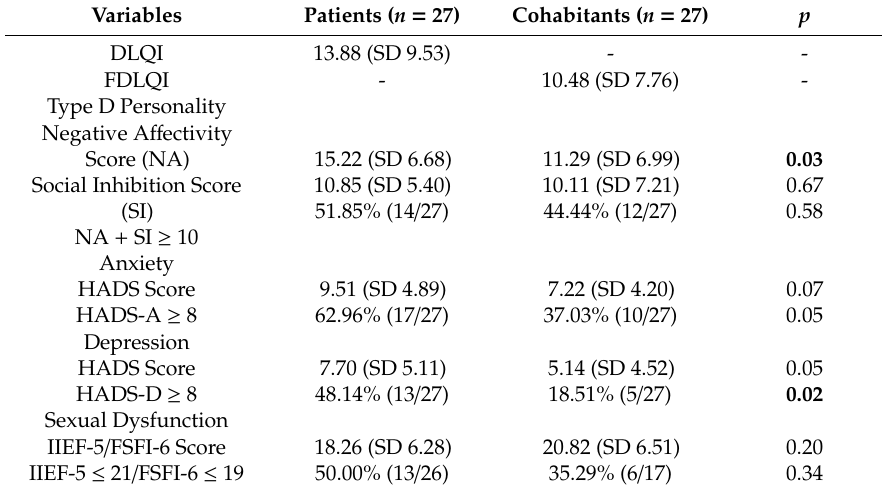
Table 1. Patients and cohabitants’ questionnaires results.